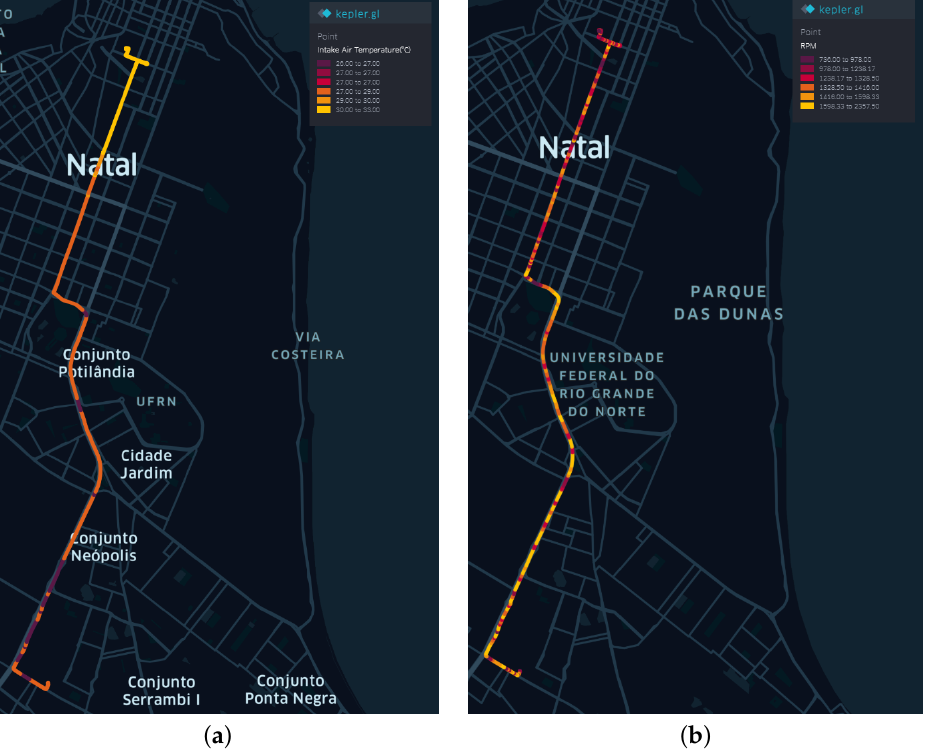
Figure 3. Vehicle variables on a day of the week—Tuesday. ( a ) Intake Air Temperature ( ◦ C) measure- ments. ( b ) RPM measurements.